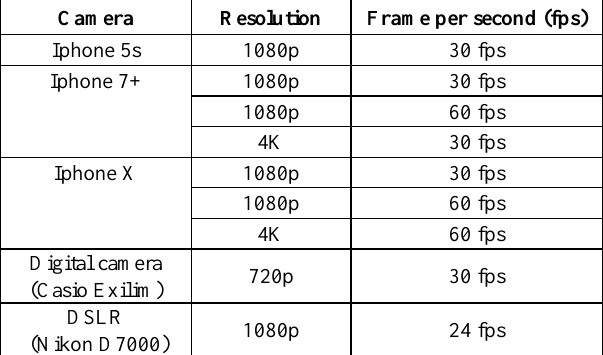
Figure 3. Theorem of